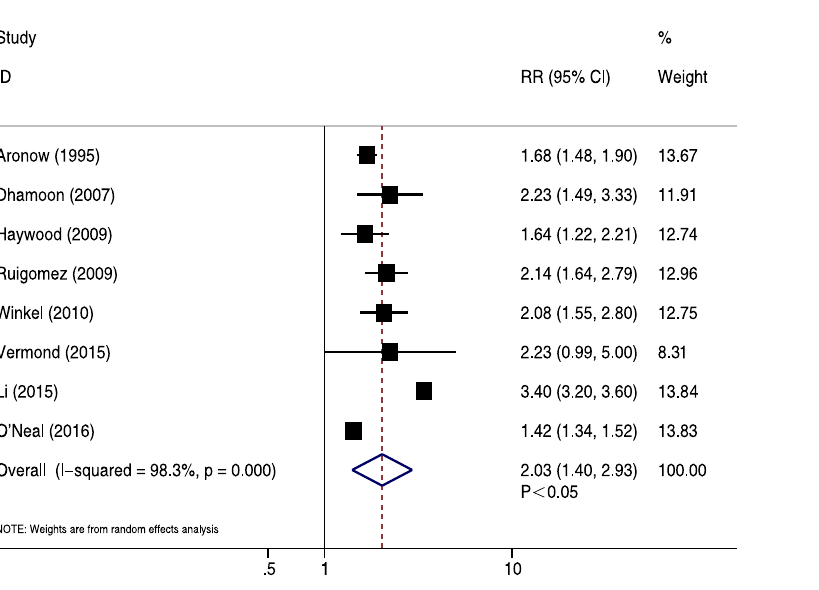
Figure 6. Forest plot showing the comparison between AF and non-AF patients in the pooled analysis of crude relative risk for cardiovascular